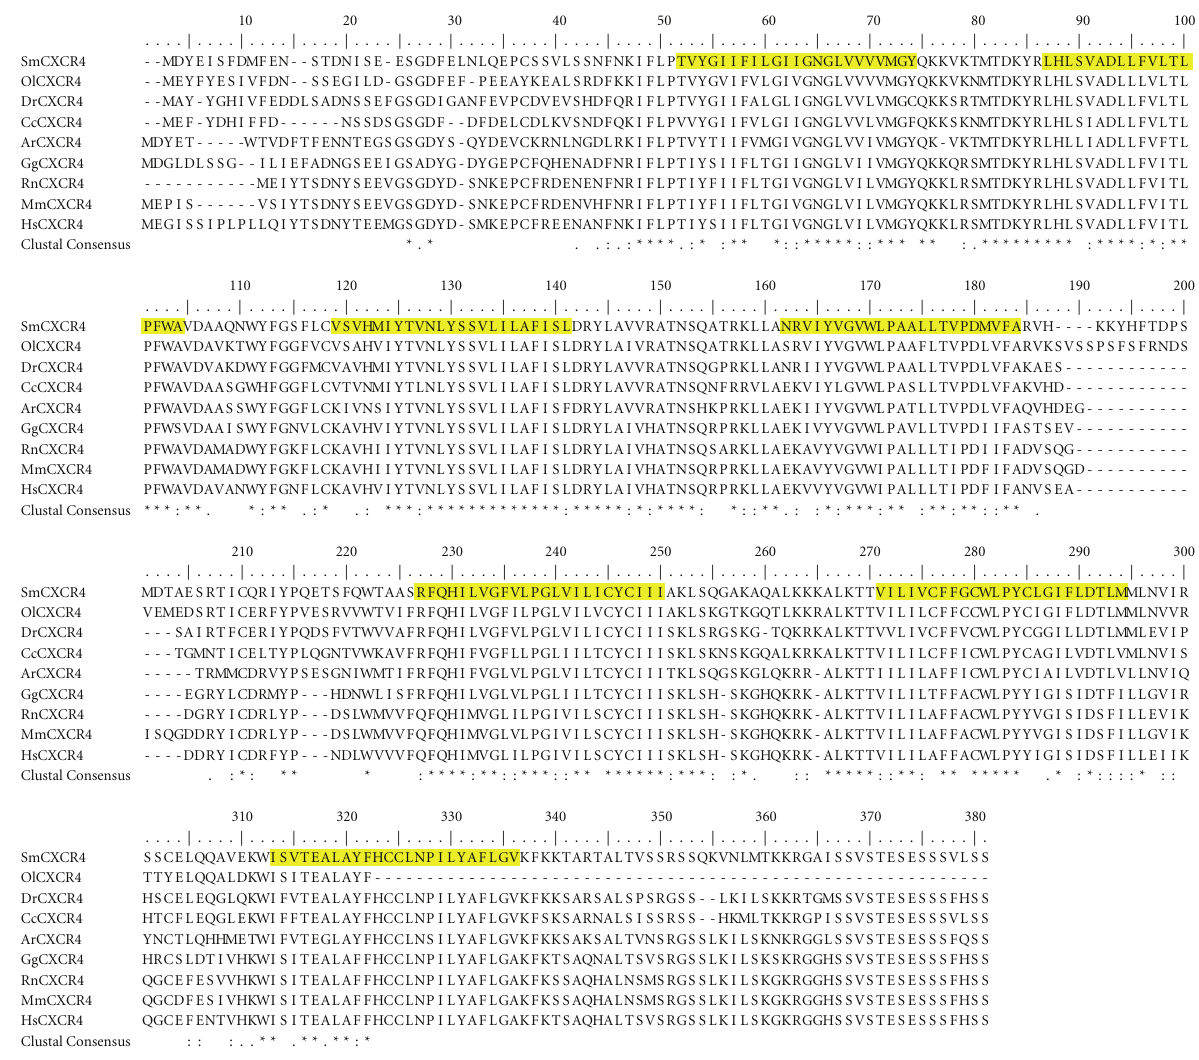
- -MDYEI SFDMFEN- - STDNI SE- ESGDFELNLQEPCSSVLSSNFNKI FLPTVYGI I FI LGI IGNGLVVVVMGYQKKVKTMTDKYRLHLSVADLLFVLTL OlCXCR4 - -MEYFYES IVFDN- - SSEGI LD-GSGDFEF - PEEAYKEALSRDFKKI FLPTVYGVI FVLGIVGNGLVVVVMGYQKKVKNMTDKYRLHLSVADLLLVLTL DrCXCR4 - -MAY-YGHIVFEDDLSADNSSEFGSGDIGANFEVPCDVEVSHDFQRI FLPTVYGI I FALGL IGNGLVVLVMGCQKKSRTMTDKYRLHLSVADLLFVLTL CcCXCR4 - -MEF -YDHI FFD- - - - - -NSSDSGSGDF - -DFDELCDLKVSNDFQKI FLPVVYGI I FVLGI IGNGLVVLVMGFQKKSKNMTDKYRLHLS IADLLFVLTL ArCXCR4